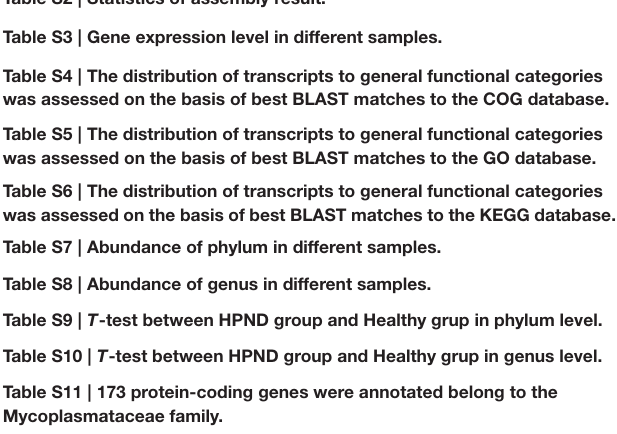
Table S1 | Statistics for sequencing data. Table S2 | Statistics of assembly result. Table S3 | Gene expression level in different samples.